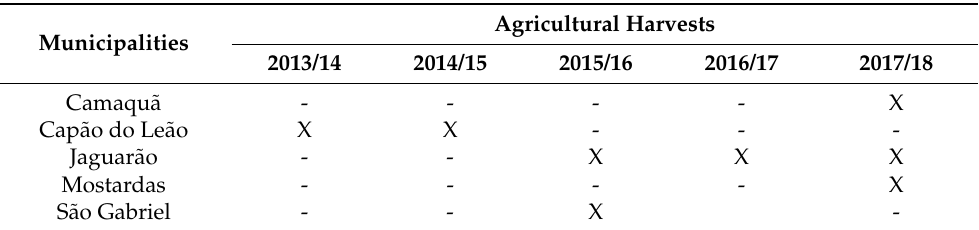
Table 1. Municipalities in the inoculant validation areas in Rio Grande do Sul. Agricultural harvests 2013/14—2017/18.